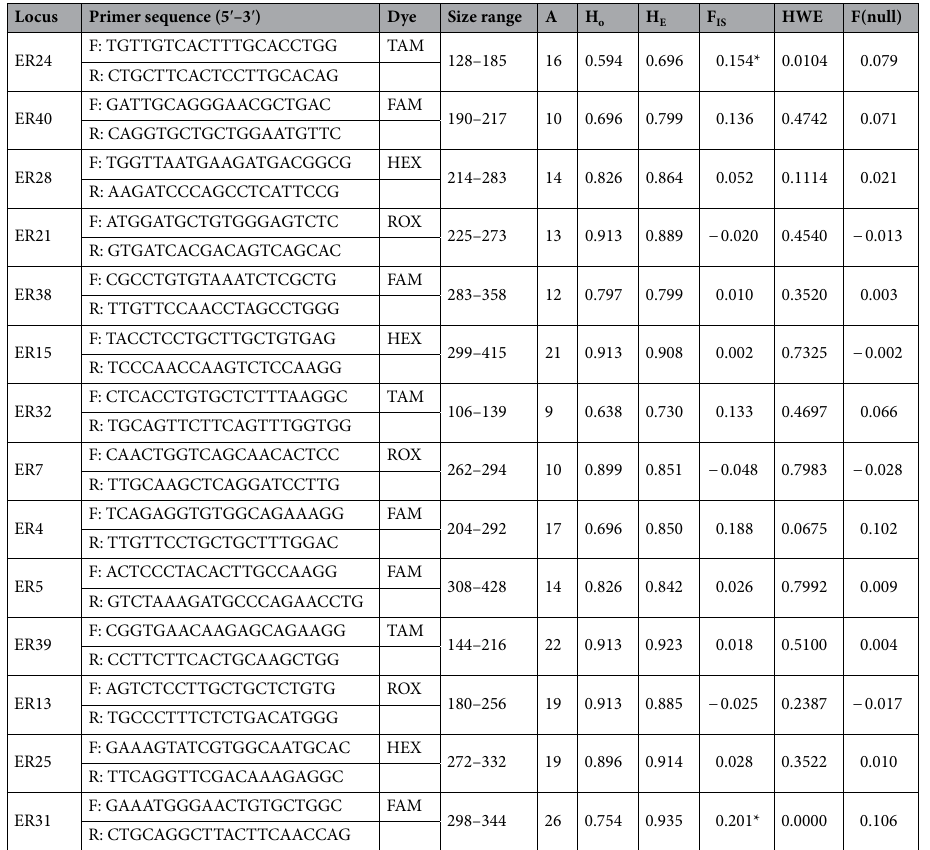
Table 1. The characterization of three multiplex PCR sets for the amplification of 14 microsatellite loci in 69 unrelated samples of European Robin. Column headings are as follows: Size range—size of fragments obtained during PCR, including flanking region; A—number of alleles; H O —observed heterozygosity; H E —expected heterozygosity; F IS —fixation index (*—F IS value significant after Bonferroni correction, 200 randomizations, adjusted P -value = 0.00357), HWE— P- value of Hardy–Weinberg equilibrium exact test, F(null)—null